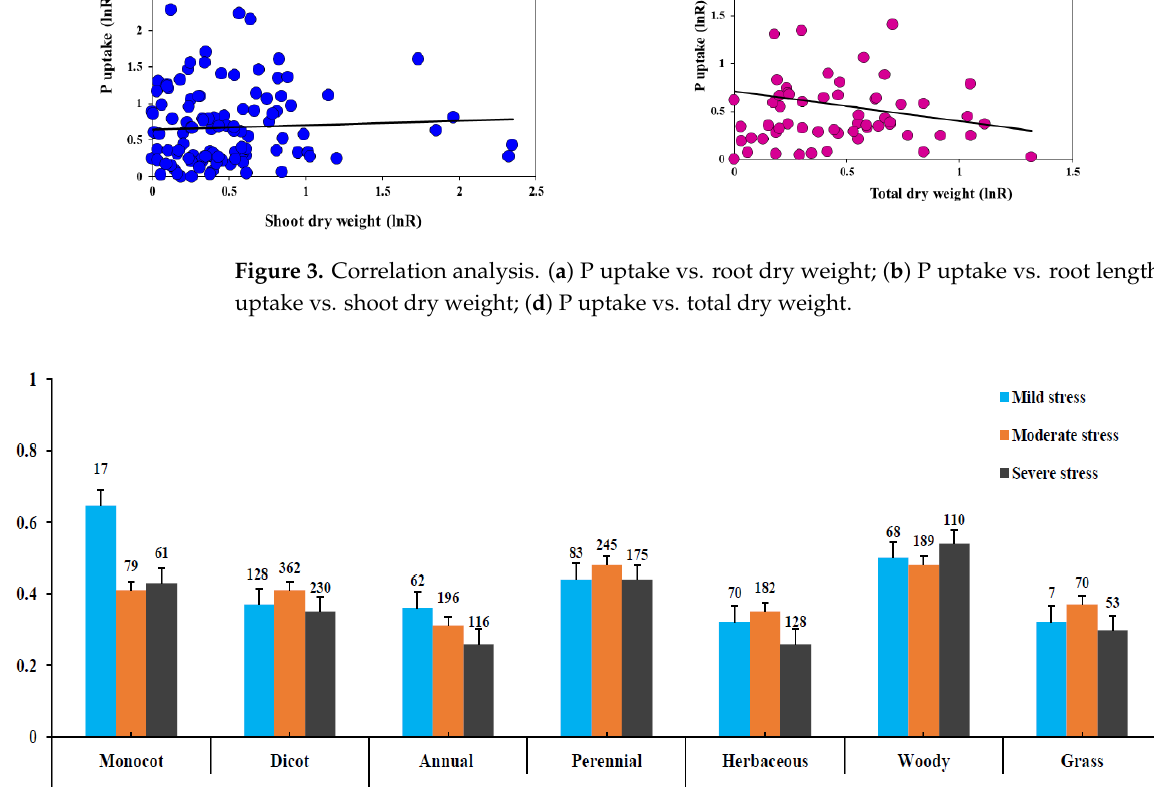
Figure 3. Correlation analysis. ( a ) P uptake vs. root dry weight; ( b ) P uptake vs. root length; ( c ) P uptake vs. shoot dry weight; ( d ) P uptake vs. total dry weight.